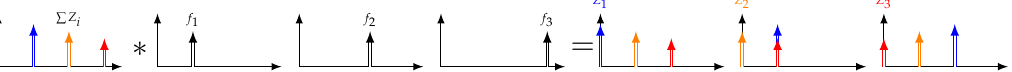
Figure 4. Conceptual representation of impedance spectroscopy based on multi-frequency excitation and Fourier analysis in frequency domain.